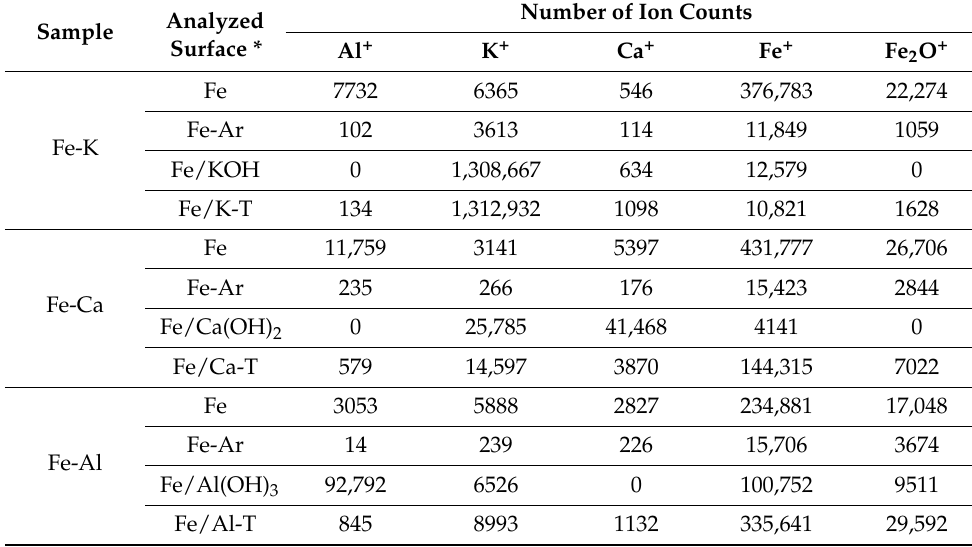
Table 1. TOF-SIMS ion counts from the surfaces of the iron